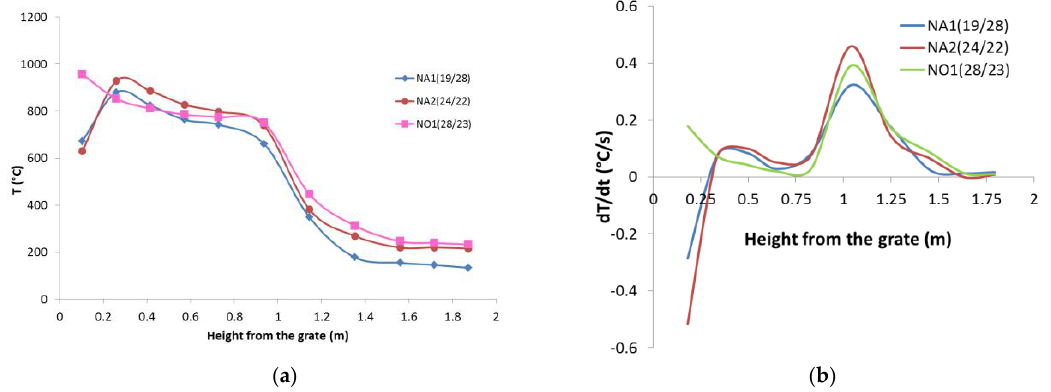
Figure 3. Thermal profile inside the gasifier in the gasification of hazelnut shells (N): ( a ) Temperatures measured in selected tests along the vertical axis ( z ); ( b ) Heating rate of the particles moving downward.